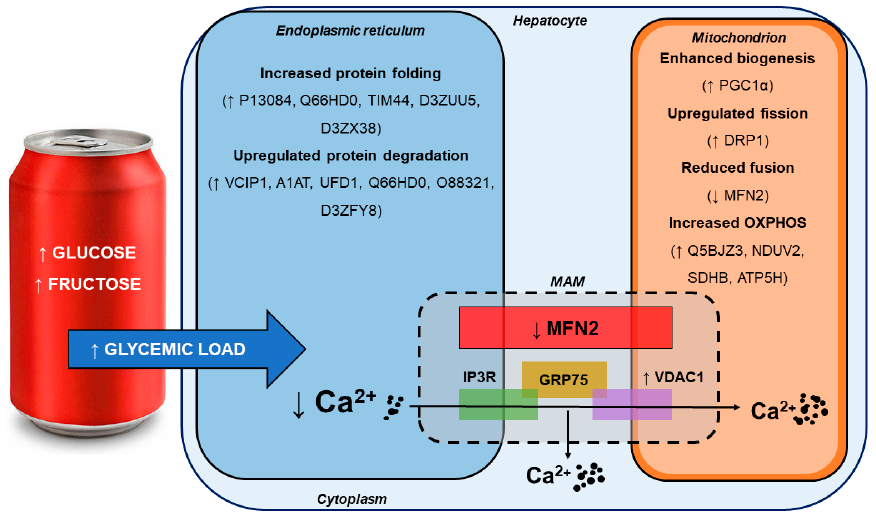
Figure 6. Summary of findings demonstrating SSB-mediated effects on hepatic ER stress and its impact on the mitochondrion.